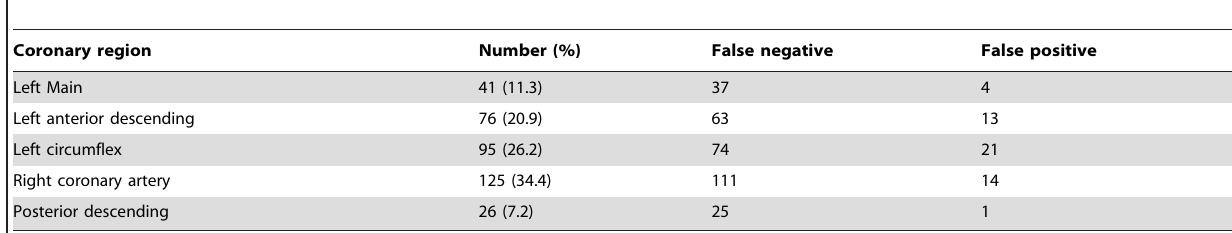
Table 2. The coronary artery calcifications that were the main reason for discordance, based on Agatston risk category shift